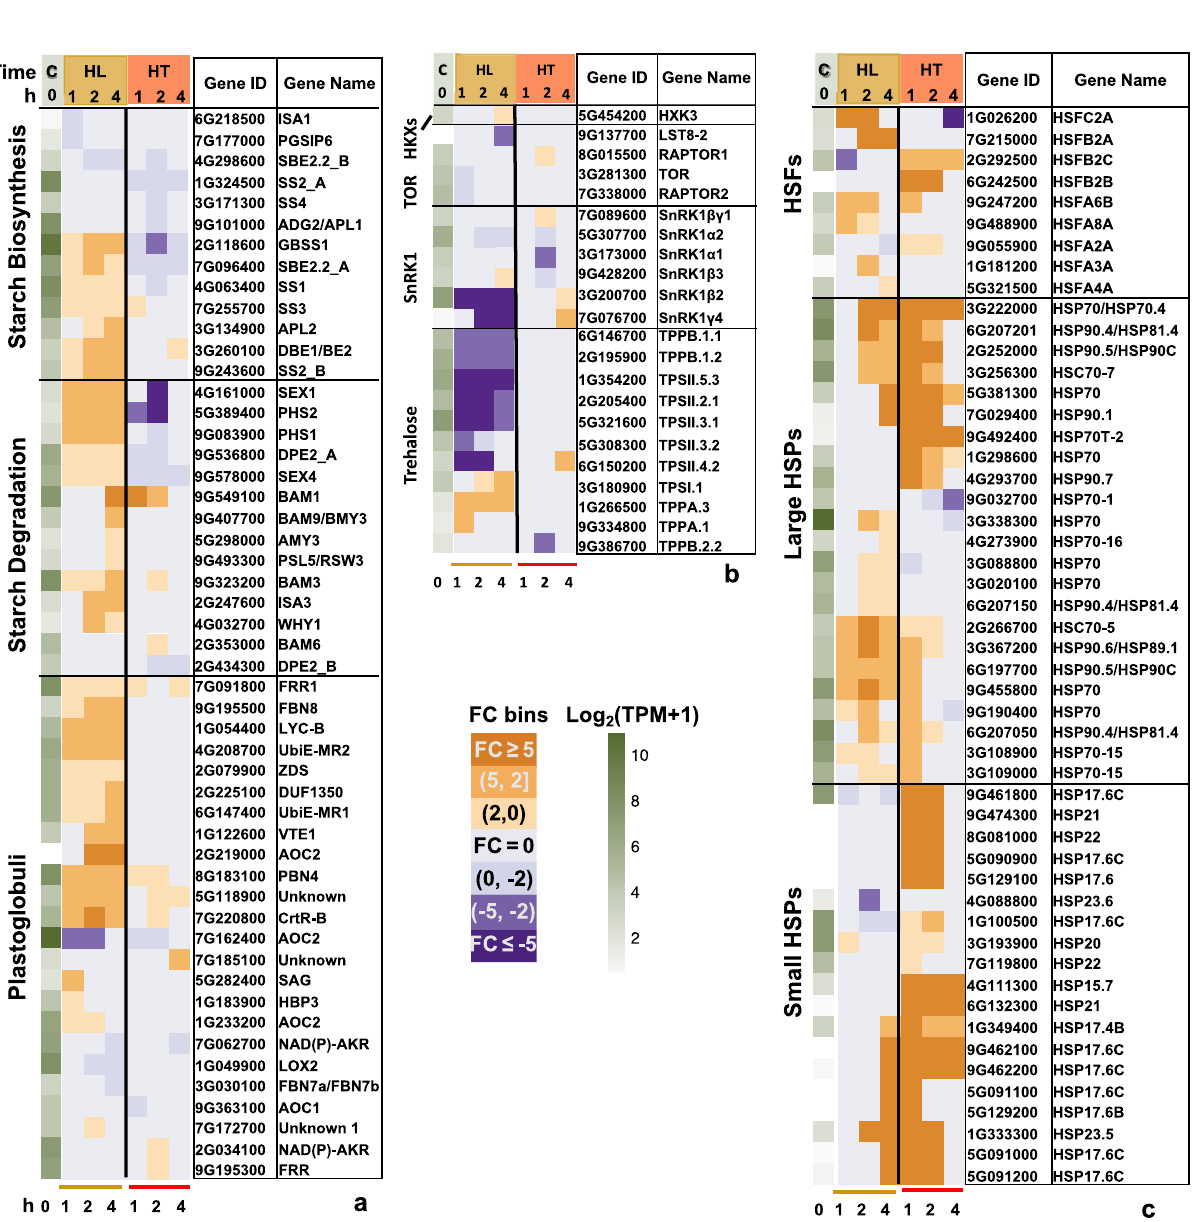
Fig. 4 High light and high temperature differentially regulated genes involved in several key pathways. a , b High light induced genes involved in starch biosynthesis/degradation and genes encoding plastoglobuli-localized proteins; b high light down-regulated many genes of the sugar-sensing pathways. c Both high-light- and high-temperature-induced genes encoding heat shock transcription factors (HSFs) and heat shock proteins (HSPs), but the induction was much quicker under high temperature than under high light. The fi rst green column displays log 2 (mean TPM + 1) at ctrl_0h (at the start of treatments, C). TPM, transcripts per million, normalized read counts. Heatmap displays the fold change (FC) bin of DeSeq2 model output values at 1, 2, and 4 h of high light or high temperature versus control at the same time point ( q < 0.05). FC bins: highly induced: FC ≥ 5; moderately induced: 5 > FC ≥ 2; slightly